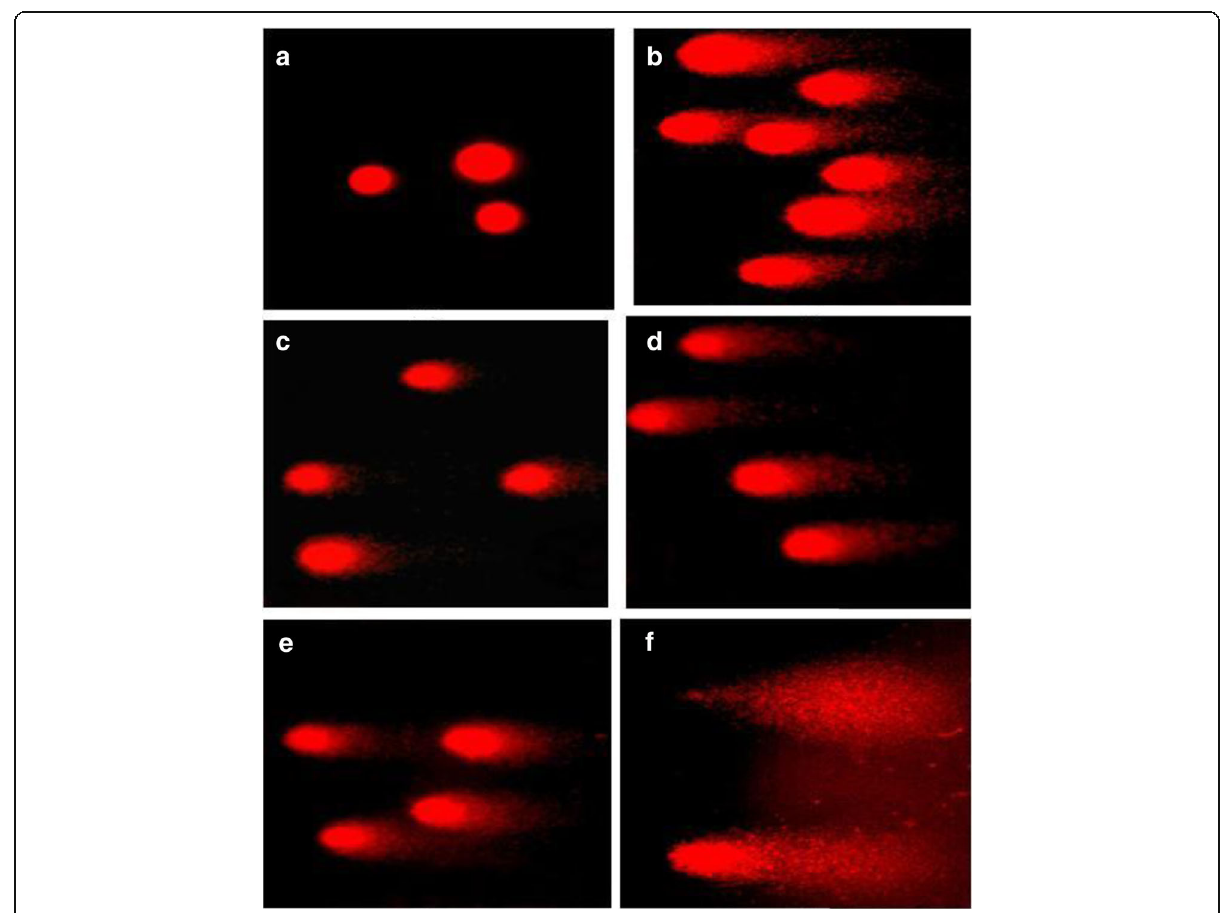
Fig. 7 Comet formation by single cell gel electrophoresis of HEp - 2 cells after treatment at different concentrations of the water extract of Semecarpus parvifolia leaves; ( a ) untreated, ( b ) Cyclohexamide as the positive control (5 mM; 25 μ L), 150 ( c ), 300 ( d ), 600 ( e ), 900 μ g/mL ( f ) of the plant extract